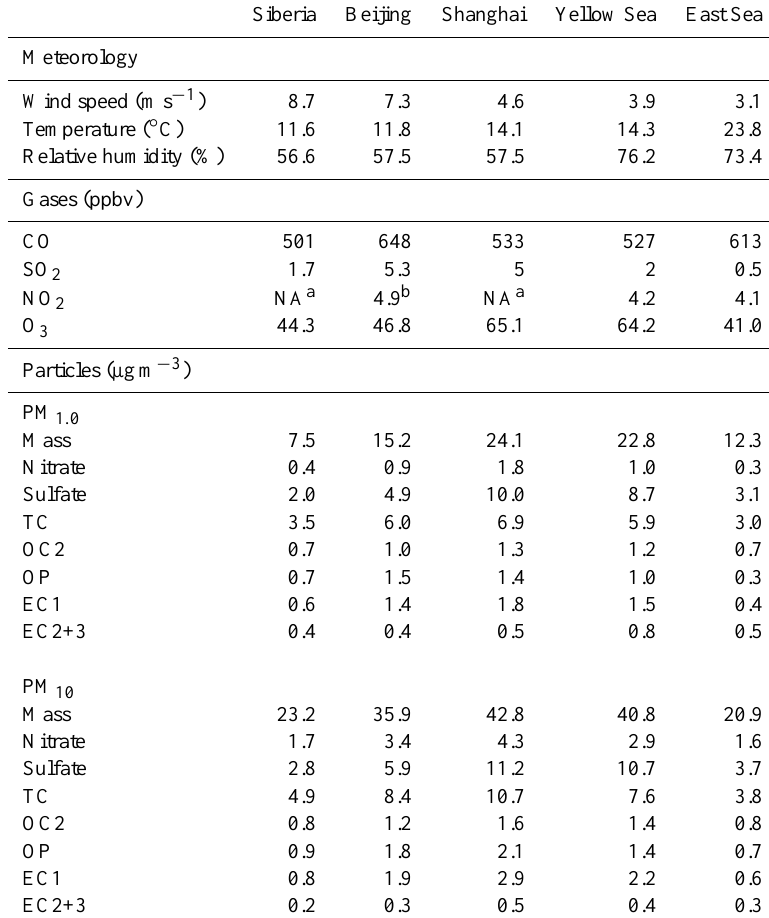
Table 5. Meteorological and chemical characteristics of the 5 air mass